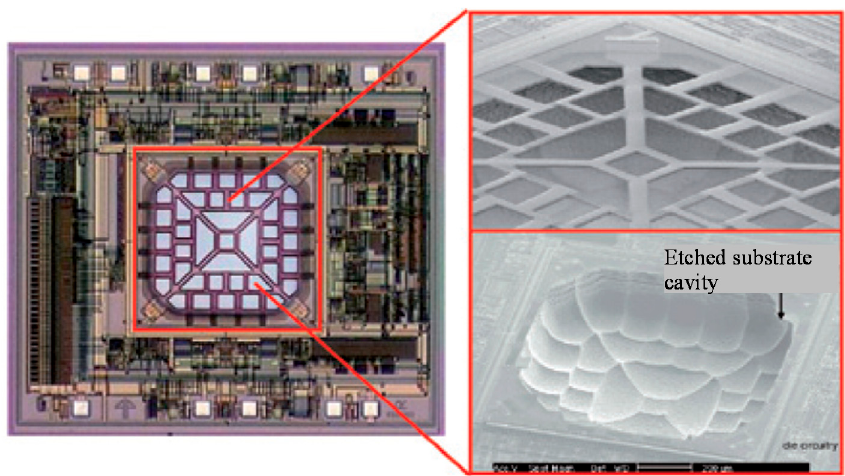
Figure 7. Die photo and SEM image of an integrated convective accelerometer from MEMSIC [68].